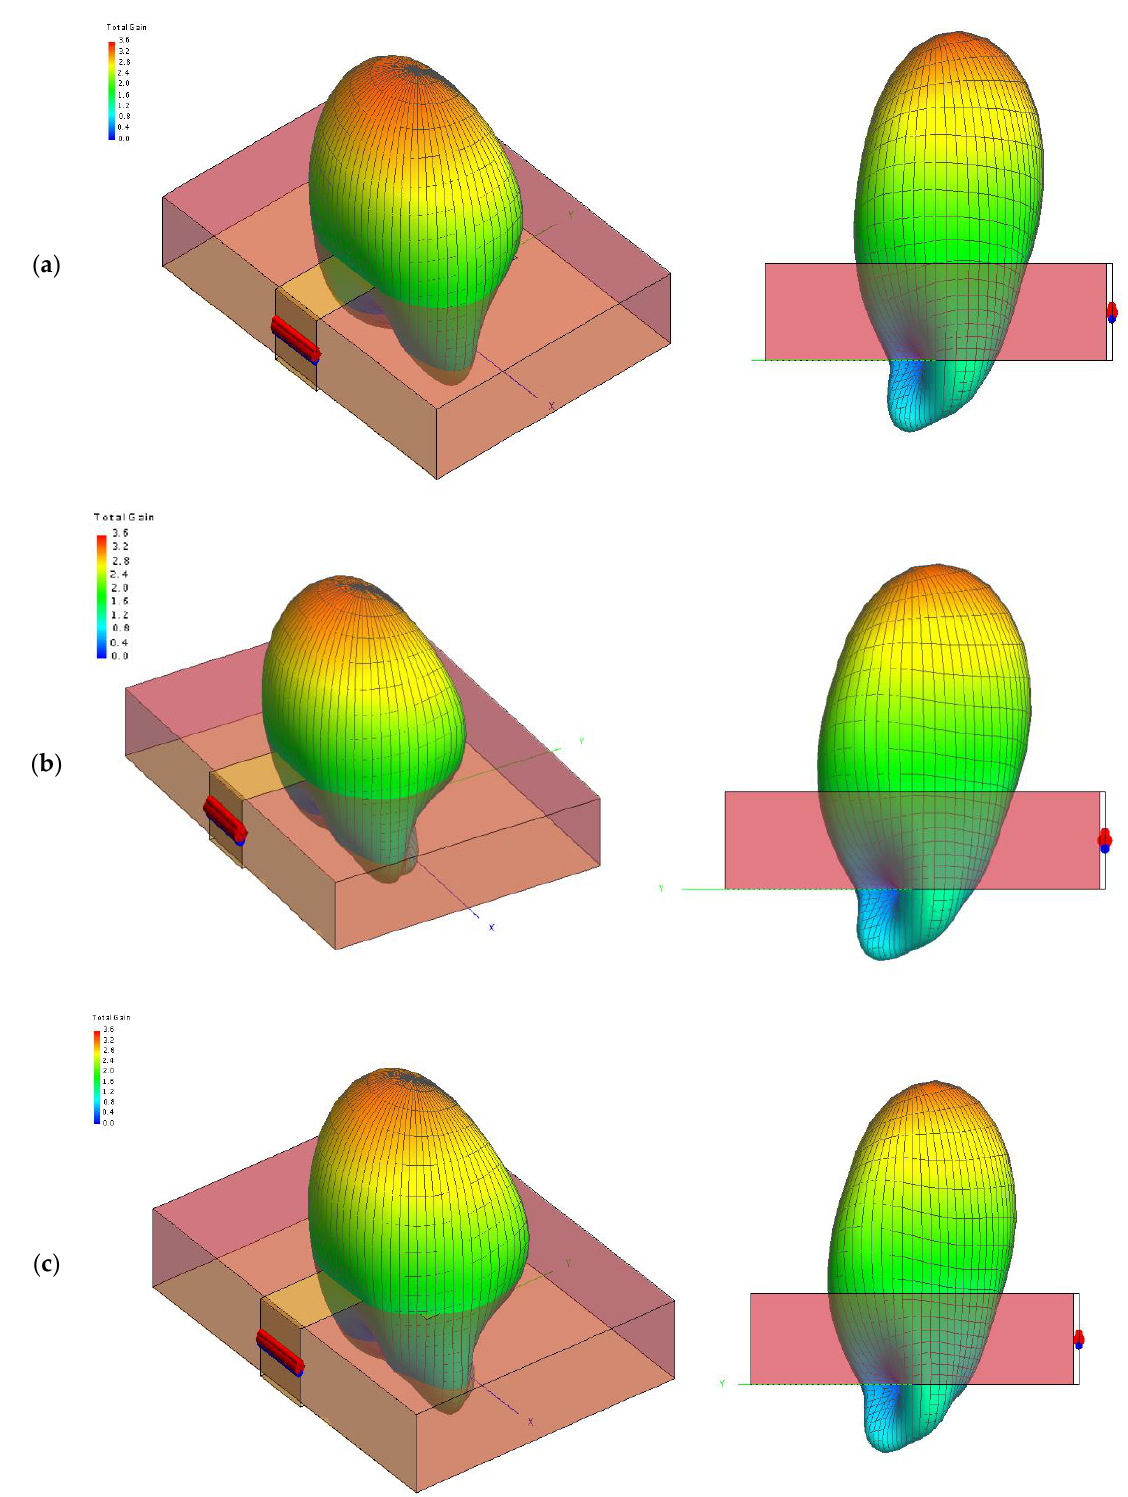
Figure 10. The three-dimensional (3D) view of radiation pattern for the proposed 5G antenna model at different frequencies. ( a ) 27.51 GHz; ( b ) 28.0 GHz; ( c ) 28.35